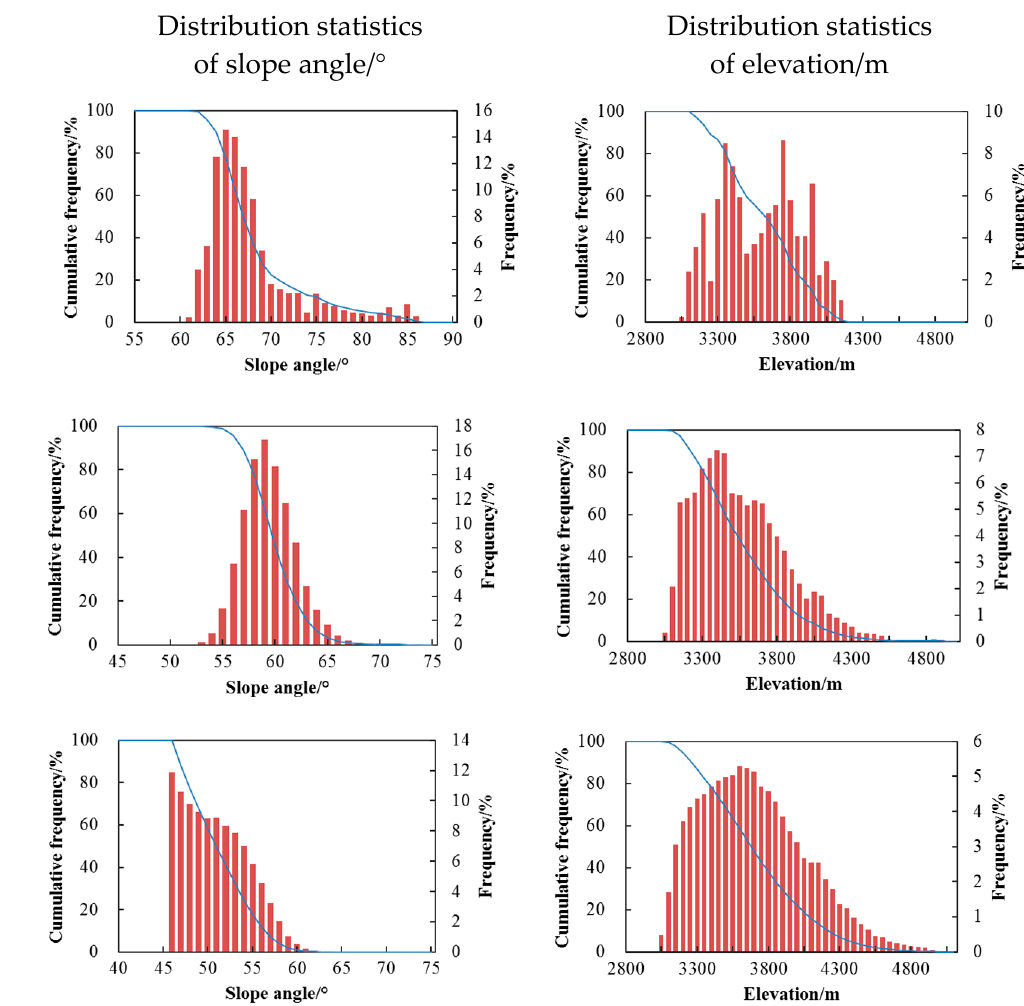
Figure 7. The distribution of slope and elevation of the identified rockfall source areas within different susceptibility classes.